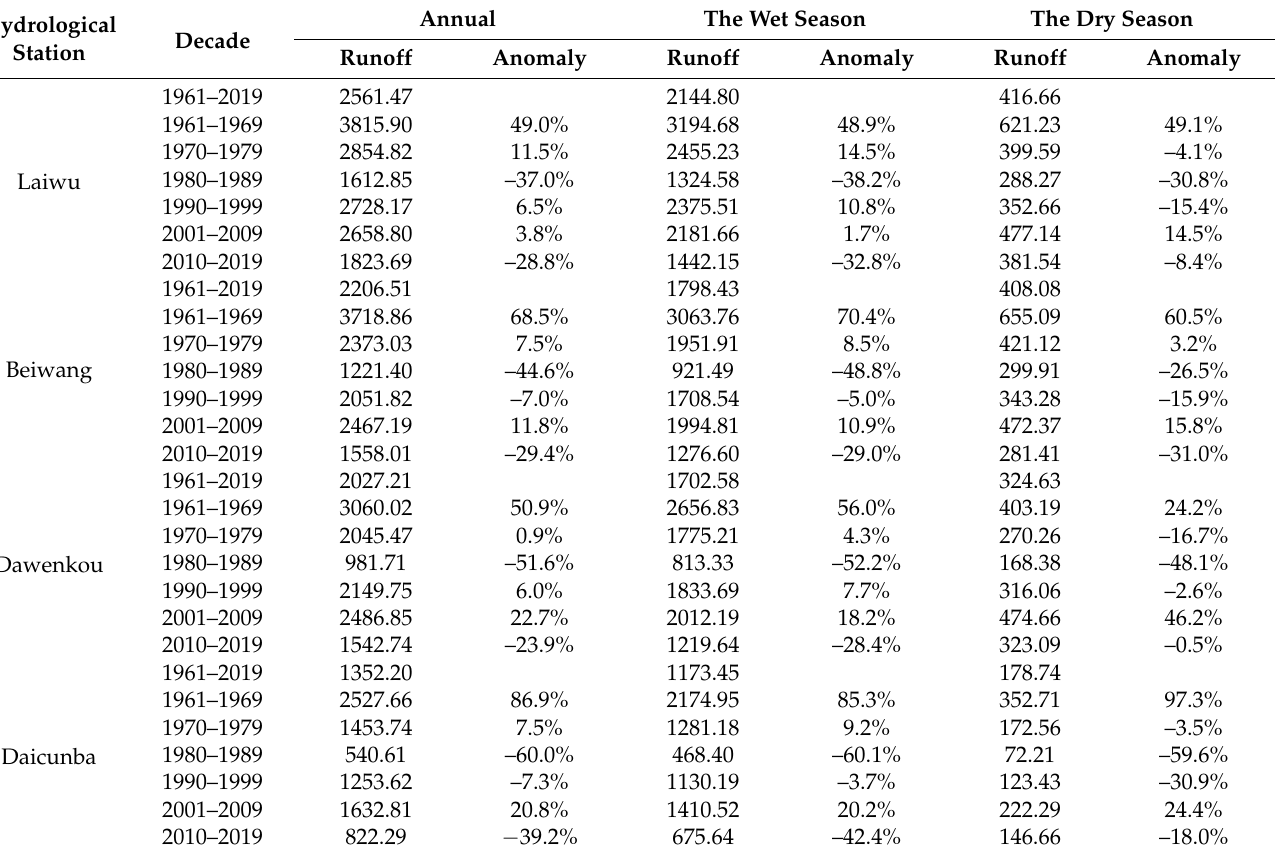
Table 2. An examination of the variation tendencies for interannual runoff in the Dawen River